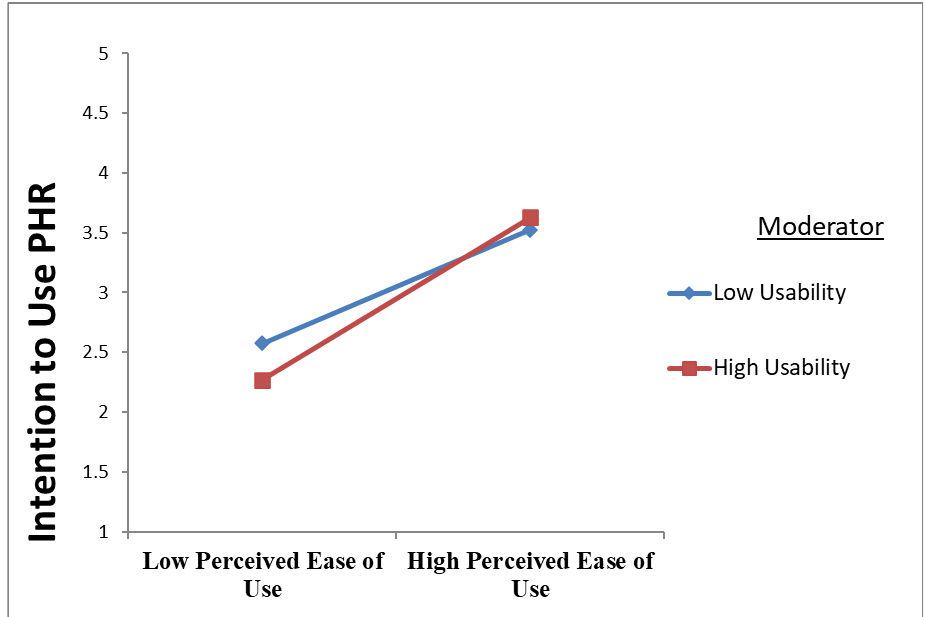
Figure 2. Privacy ’s Positive Moderating Role on the Association between Perceived Ease of Use and Intention to Use PHR.